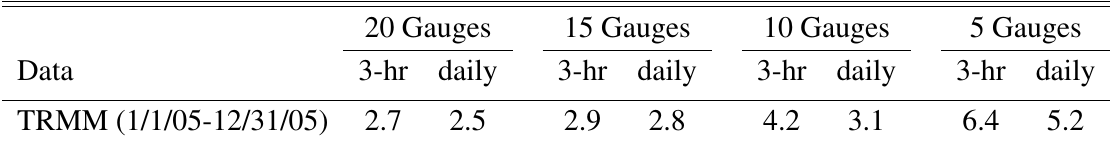
Table 2. The number of time steps, n the rain gauge